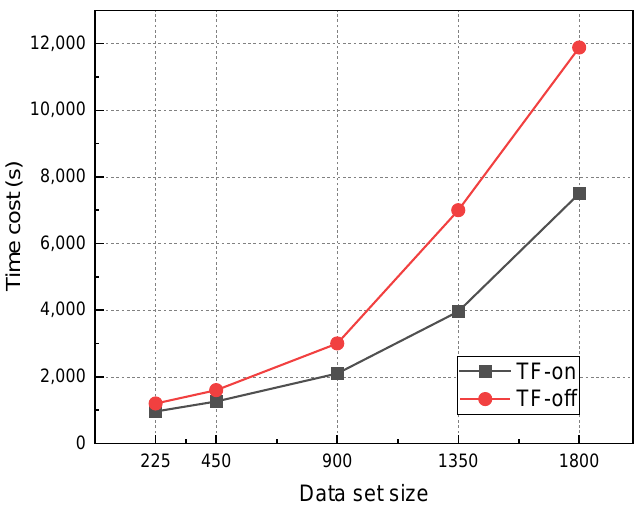
Figure 12. The influence of transfer learning on training efficiency.